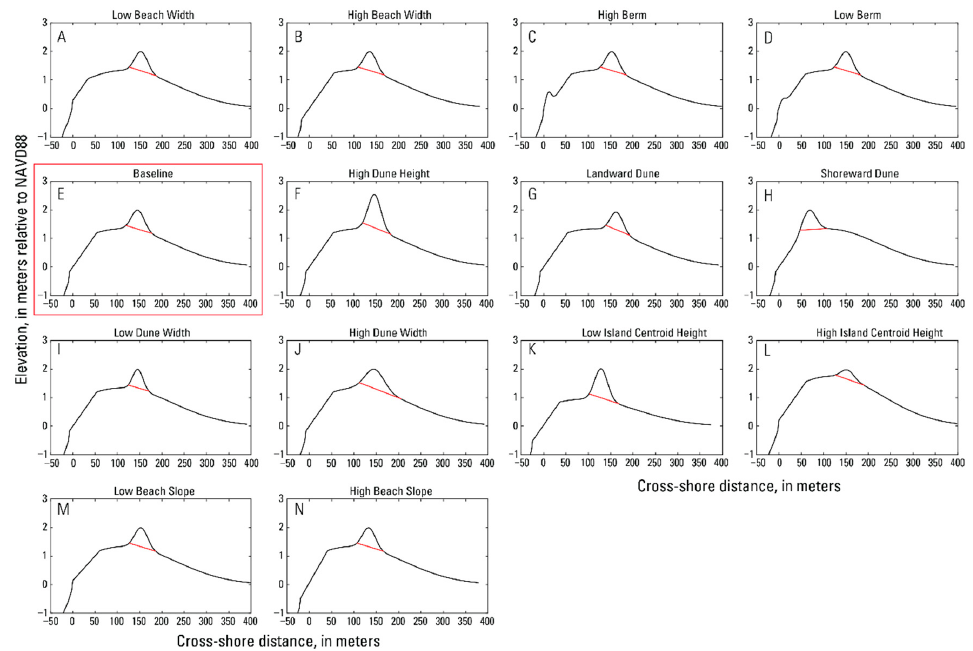
Figure 4. Idealized initial profiles varying island characteristics as described in Table 1;( A ) low beach width case, ( B ) high beach width case, ( C ) high berm height case, ( D ) low berm height case, ( E ) baseline case, ( F ) high dune height case, ( G ) landward positioned dune case, (H)